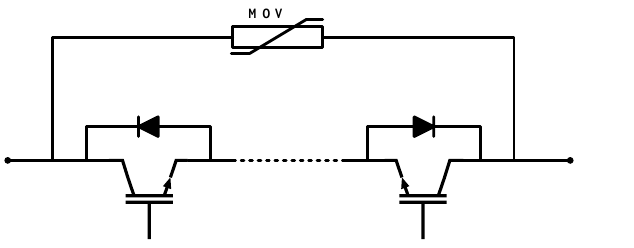
Figure 9. IGBT-based solid-state DCCB [31].